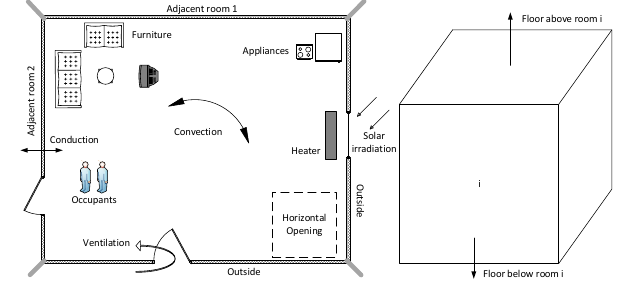
Figure 1: Configuration of the building